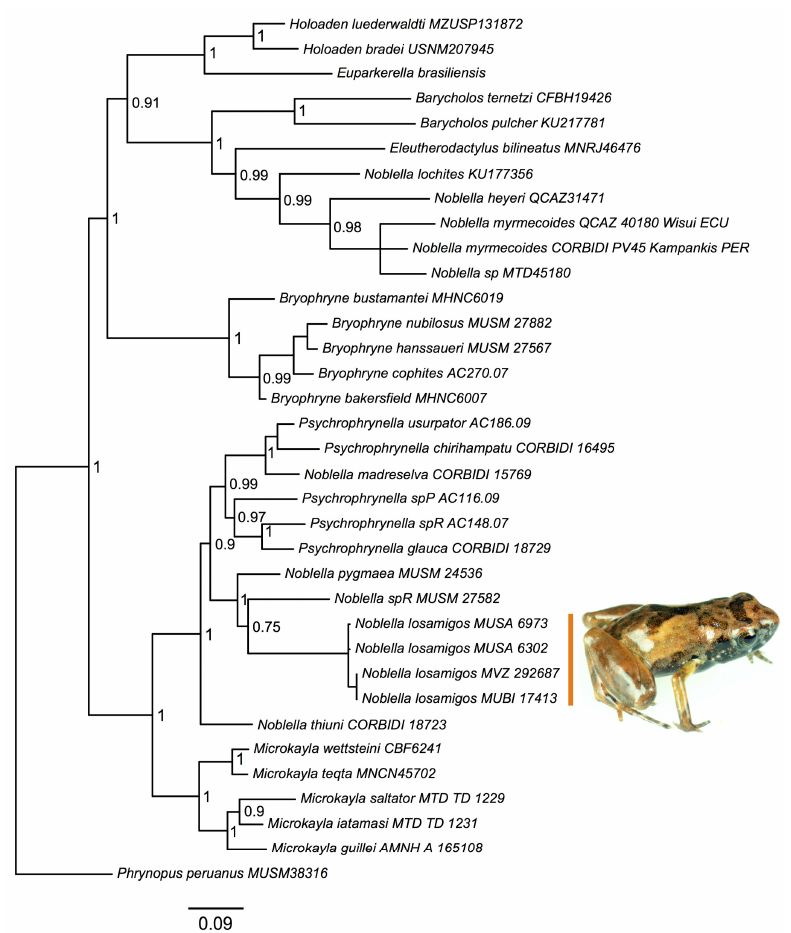
Figure 1. Phylogeny. Bayesian maximum clade-credibility tree for species included in this study based on a 2571 bp concatenated partitioned dataset analyzed in MrBayes (posterior probabilities indicated at each node).